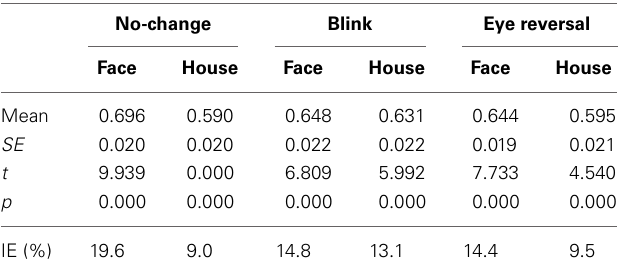
inverted objects ( N = 17).